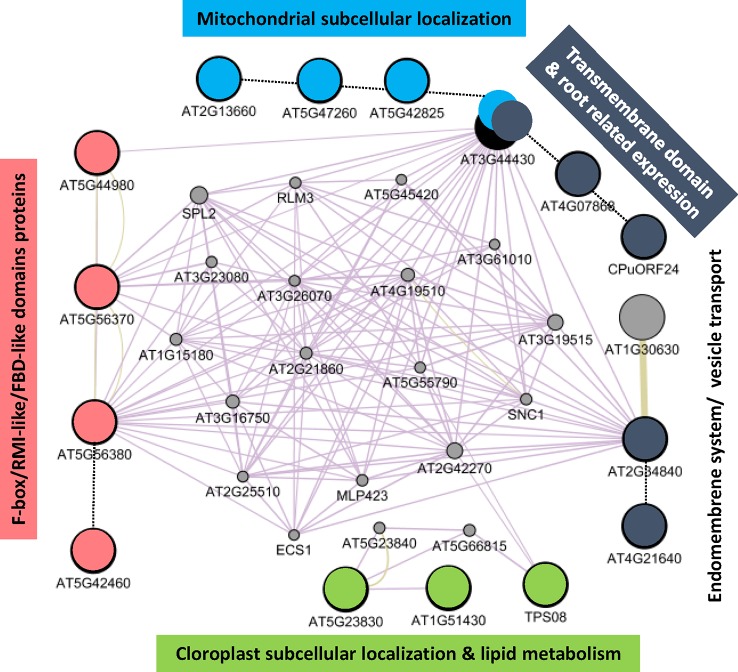
Fifteen up-regulated genes in reduced gravity conditions can be connected in a gravity-response putative pathway. Large circles shown the genes detected in the first row clusters from the previous GEDI analysis (Figure 3) and small circles are candidates to be members of a shared pathway (as detected by Genemania App in Cytoscape v3.6.1). While most of the genes have unknown function, color have been used to highlight shared features among their GO properties. Solid lines shown related features as detected by Genemania app, dotted lines have been added by manual datamining comparisons. Note that four genes expressing F-box/RMI-like proteins (in red) out of 156 genes (related examples are auxin polar transport genes as TIR-1, cell wall remodeling and even cyclins) in the genome may be key in the definition of a microgravity specific pathway characterized by the highly interconnected nodes in this graph.